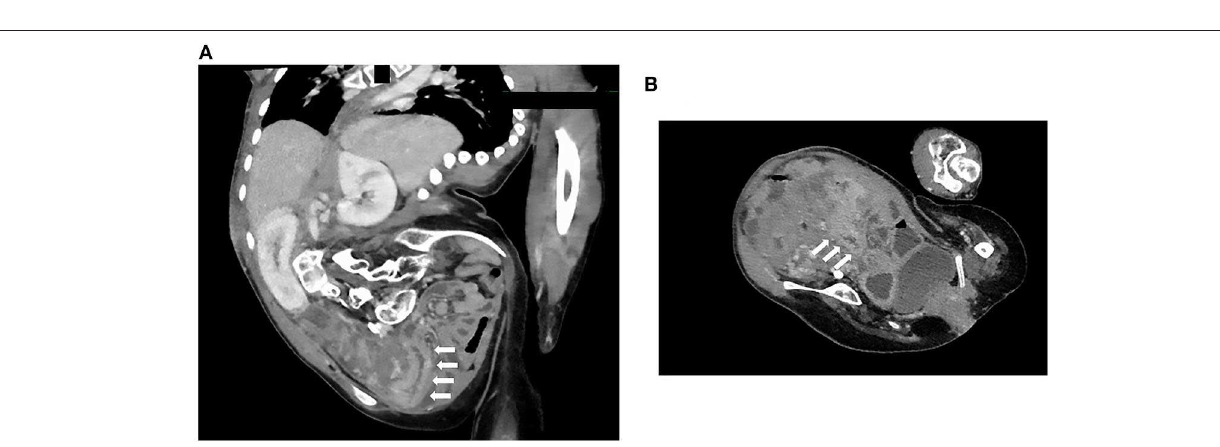
FIGURE 4 | Abdominal contrast medium-enhanced computed tomography. (A,B) The images revealed an effect of enhancing the mucosal surface and the edematous wall thickening localized from the terminal ileum to the cecum. White arrows indicate the terminal ileum and